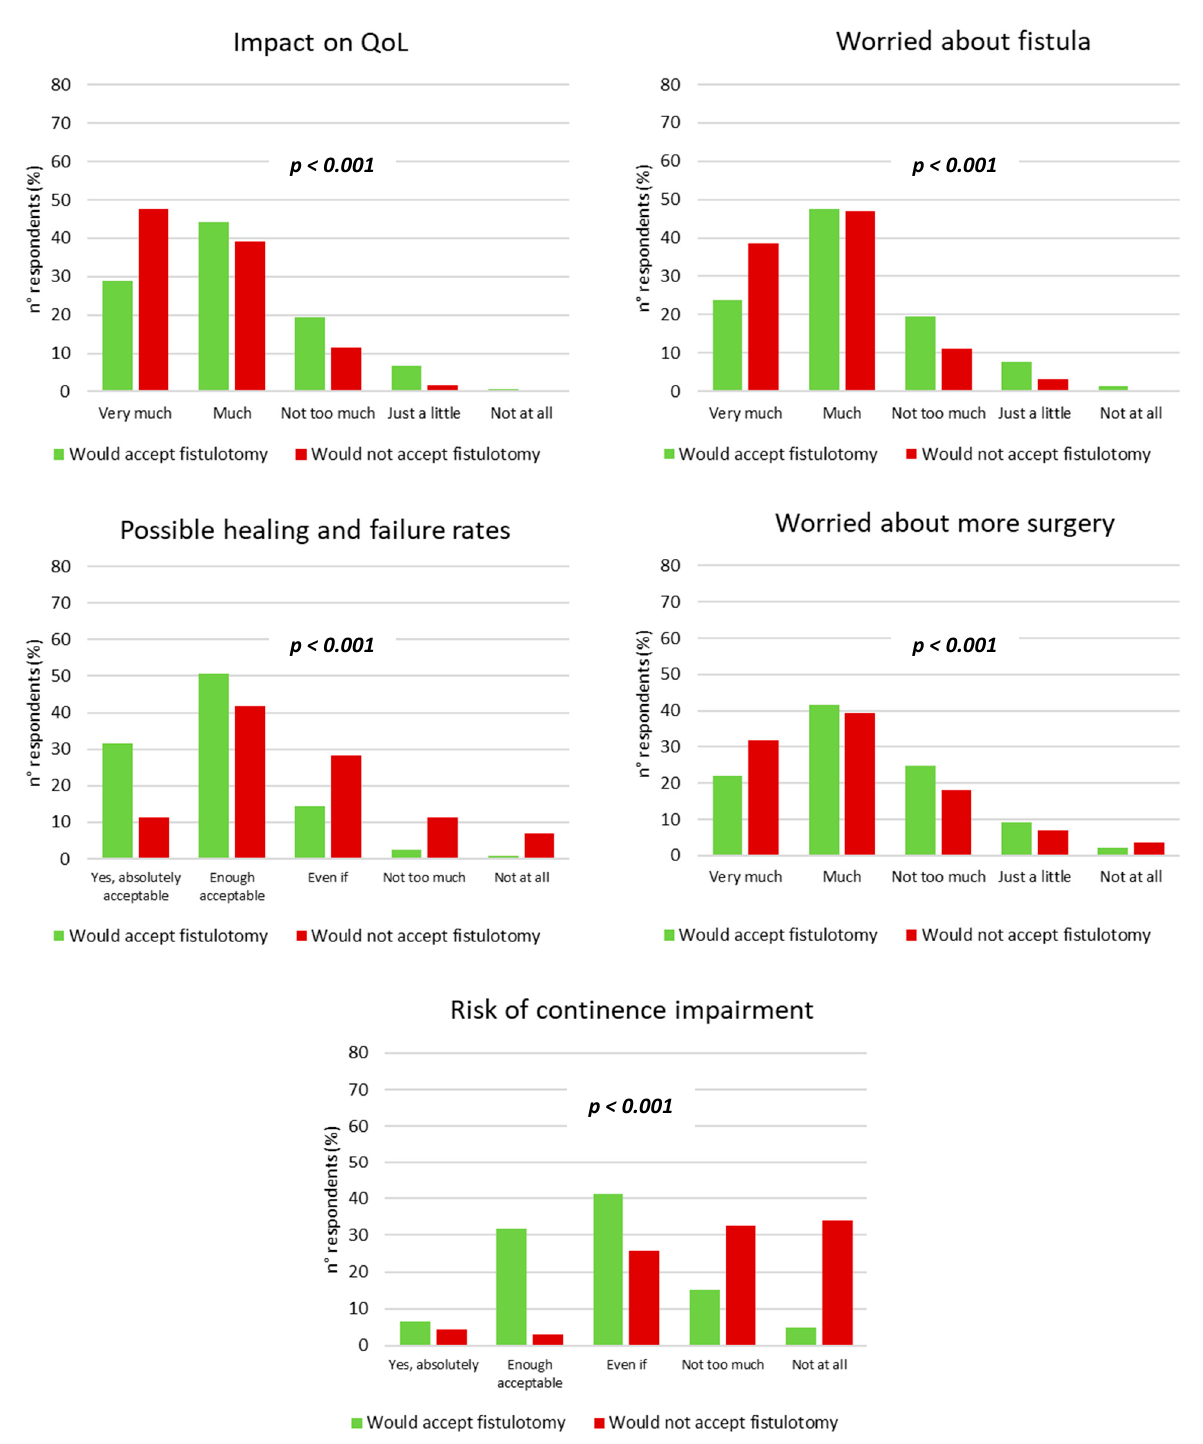
Figure 3. Comparison of respondents’ opinions between who would and would not agree to be submitted to fistulotomy in both low and high anal fistula (chi-squared test). QoL = quality of life; Even if = considerable.